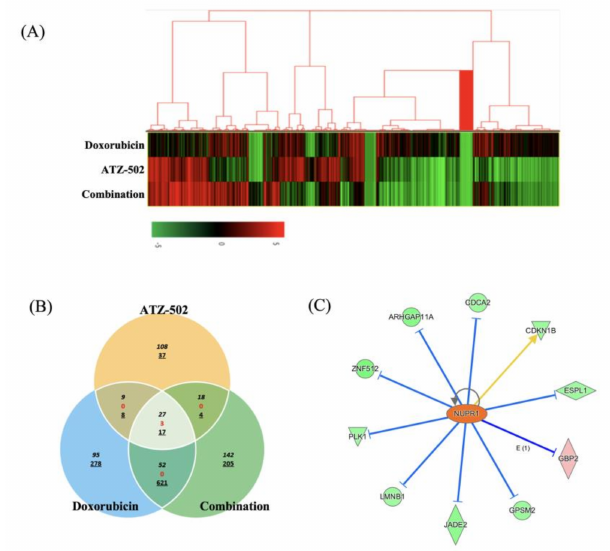
Figure 5. Differentially expressed gene (DEG) selection and identification of regulated genes using gene expression profiling. ( A ) Supervised hierarchical clustering of up- and downregulated genes between the control and the treated cells (2-fold) (Red, upregulated; Green, downregulated. ( B ) Selection of common DEGs between the single- and the combination-treatment profiles (Black, com- monly overexpressed genes; Red, change in gene expression patterns between compared groups; Underline, commonly downregulated genes). ( C ) After Ingenuity Pathway Analysis (IPA) analysis, 10 NUPR1-regulated genes were selected from 347 DEGs. Of these genes, nine genes were downreg- ulated and one gene was upregulated more than 2-fold compared to the control. (Yellow and blue line, prediction of